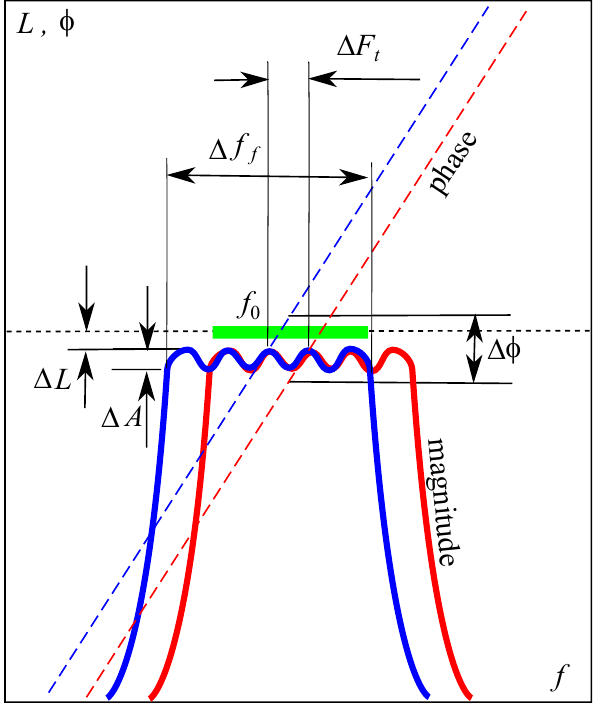
Figure 2. Frequency response of the phase shifter based on the band-pass